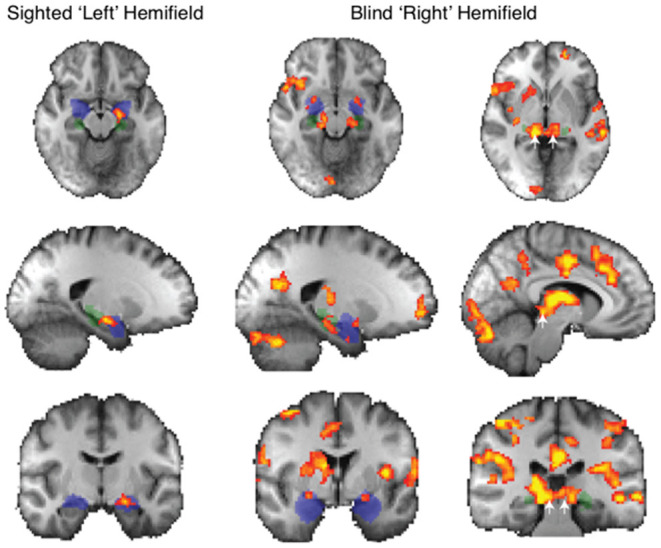
fMRI response to all face traits > neutral in patients with blindsight. Significant activity for face traits in the sighted field (left panel) and blind field (right panel, two columns). Mixed-effects analyses, P < 0.001 uncorrected for a priori regions of interest, elsewhere cluster corrected p < 0.01. Shaded blue areas are binarized Jülich-defined probabilistic maps of the amygdala, Jülich-defined LGN masks are green, and the superior colliculus is indicated by white arrows. Z-statistic range 2.3–4, radiological convention.